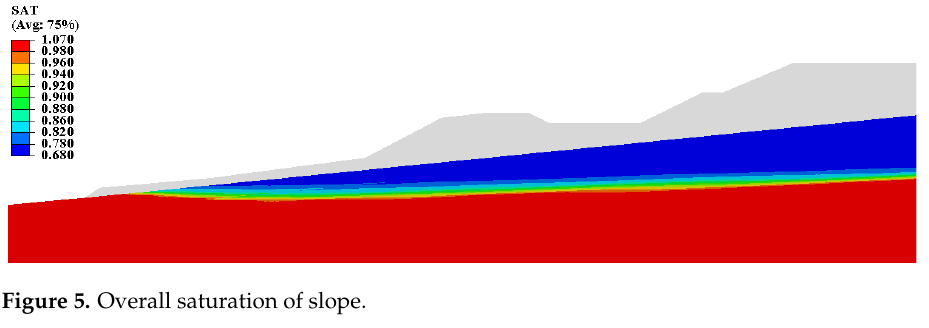
Figure 5. Overall saturation of slope.